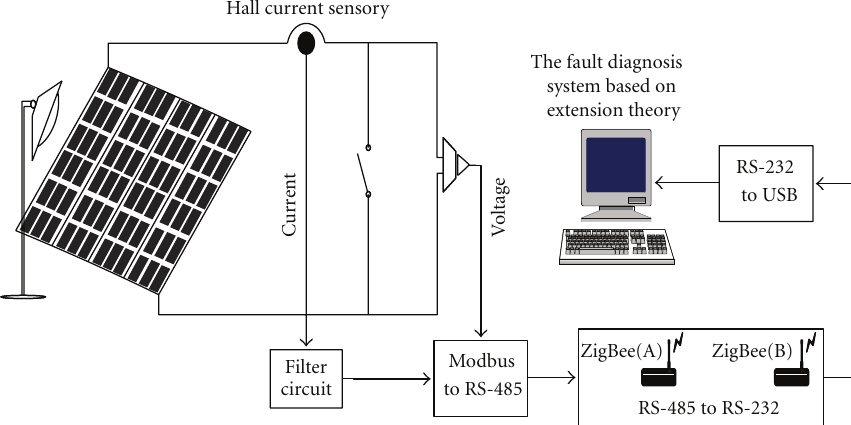
Figure 7: The architecture of diagnosis system for remote photovoltaic power